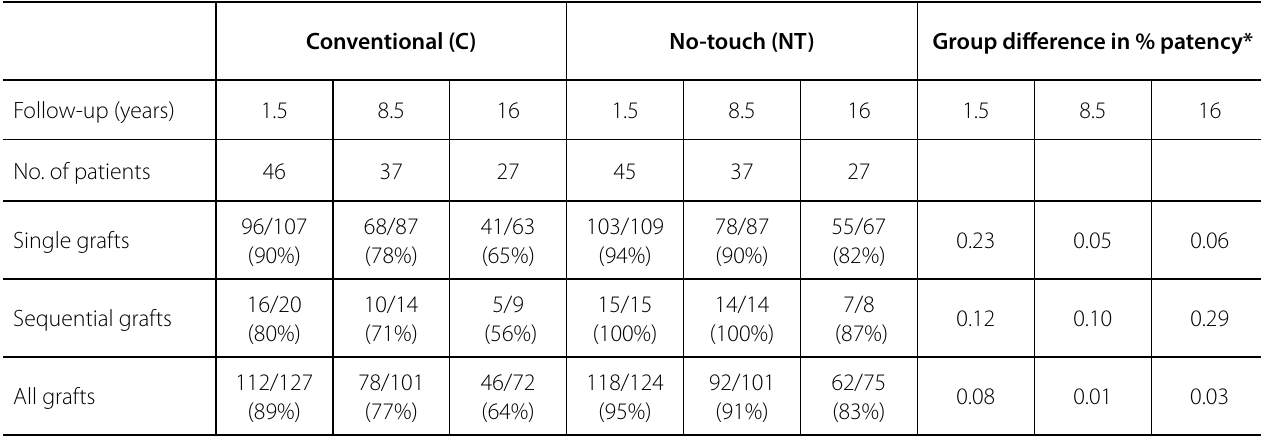
Table 1 . Ratio of number of patent grafts to total number of grafts for the two surgical techniques at three follow-up time points (Samano et al. [17] , 2015).